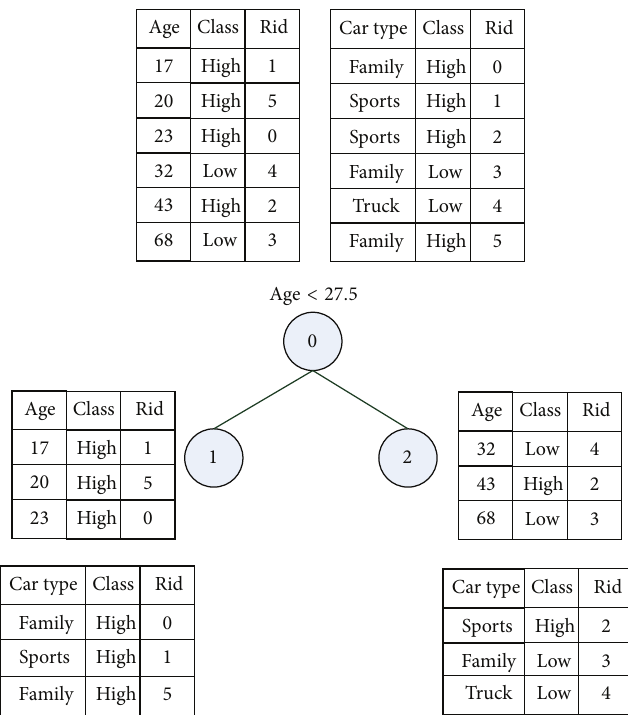
Figure 3: Splitting an attributes list into disjoint subspaces in SPRINT.